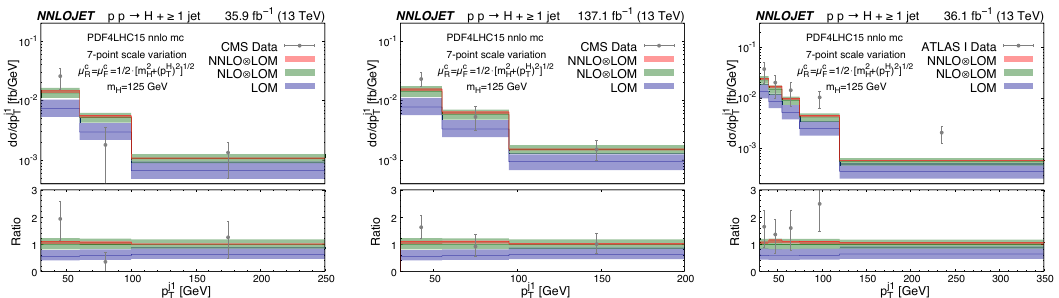
Figure 8. Transverse momentum distributions of the leading jet produced in association with a Higgs boson for CMS [ (cid:31) dt =35.9 fb − 1 ] (left) and [ L [ (cid:31) dt =36.1 fb − 1 ] (right) cuts and integrated L